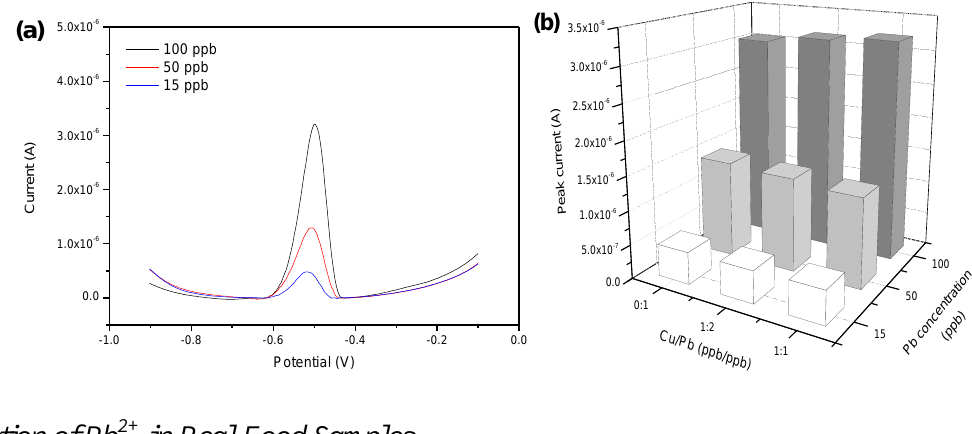
Figure 10. ( a ) SWV of rGO-SPCE for Pb 2+ solution with the coexistence of the same concentration of Cu 2+ ; ( b ) The analysis result of interference test data in the presence of Cu 2+ at different